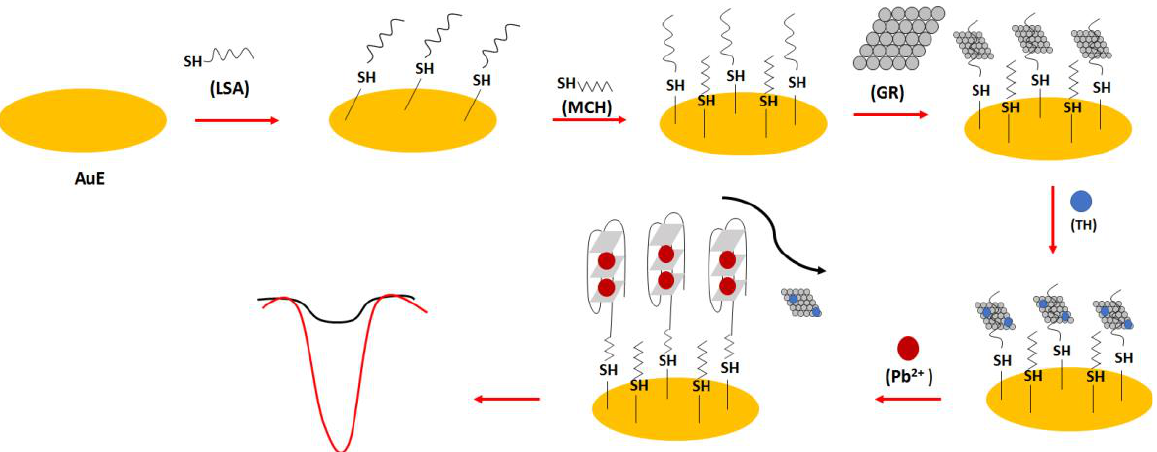
Figure 22. The sensing principle scheme of the graphene/thionine based electrochemical aptasensor towards lead ions.